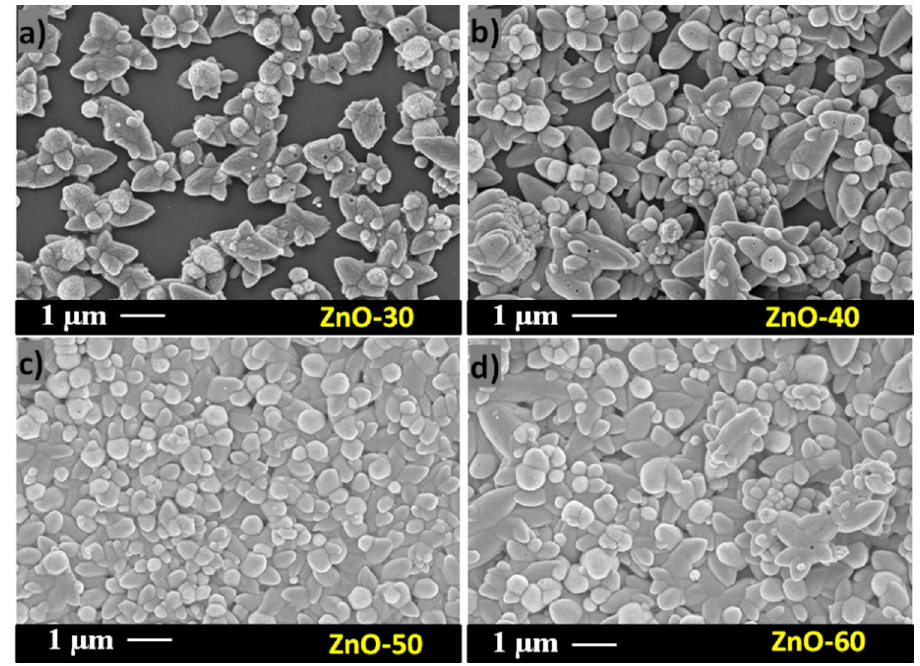
Figure 4. SEM images of the ZnO films grown in ethanol at ( a ) 30, ( b ) 40, ( c ) 50 and ( d ) 60 cycles.